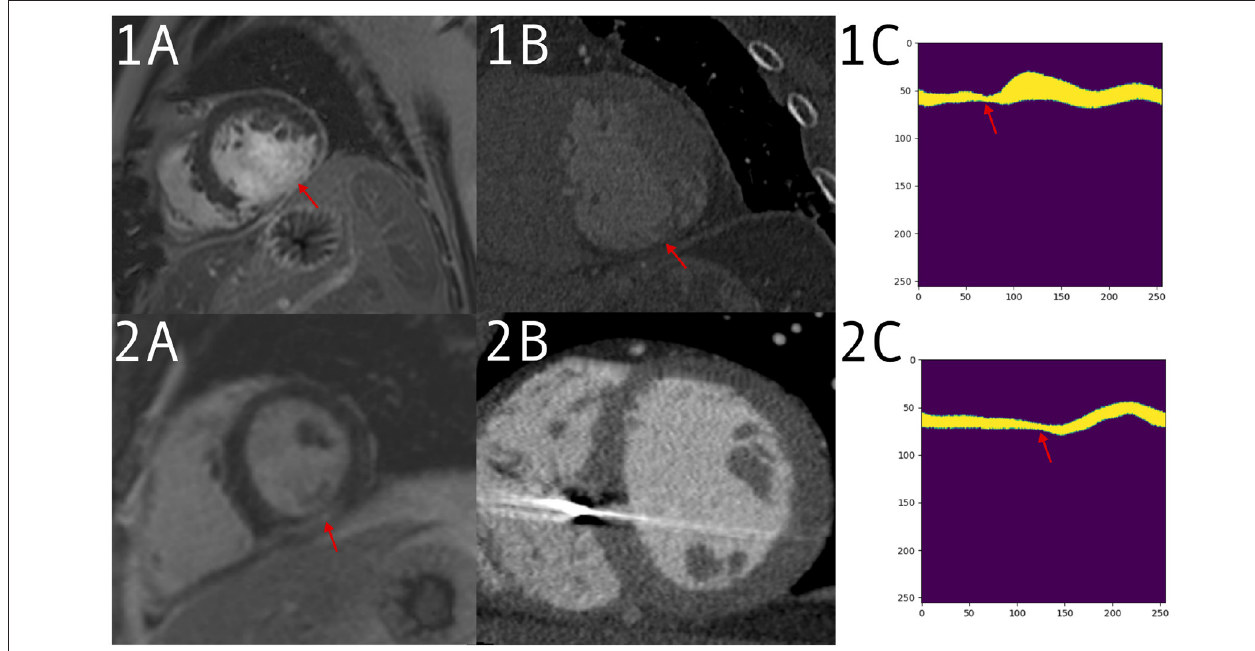
FIGURE 5 | 1: Patient with a large defect, detected correctly by both clinician and prediction network. Imaging acquired for valve replacement procedure and decreased left ventricle (LV) function from suspected infarction. (1A) A large defect on the late gadolinium enhancement (LGE) scan. (1B) The computed tomography angiography (CTA) with thinning visible in the same region. (1C) The input to the network for a mid-ventricle slice, in the form of a polar coordinates myocardium mask derived from the CTA segmentation. Thinning can be seen around the red arrow. (2) Patient with a smaller defect and less remodeling, which was detected by the network but not the clinician. Imaging performed for VT ablation planning. (2A) A positive LGE area on a mid short-axis slice. (2B) A CTA slice without an obvious defect visible. (2C) The polar mask with a change in anatomy, which is picked up by prediction network as a possible